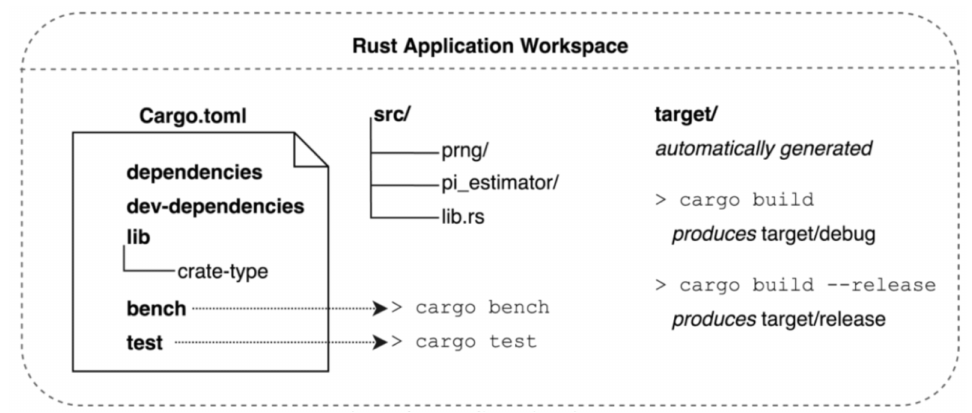
Figure 4. Rust crate